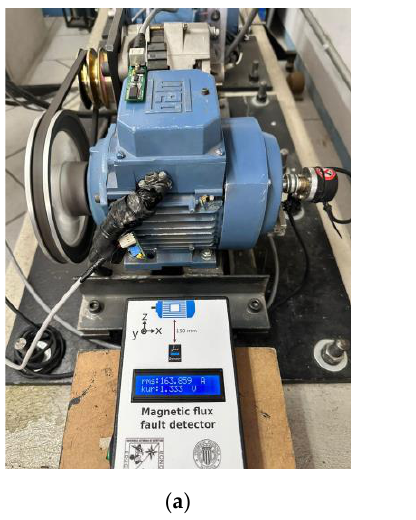
Figure 10. ( a ) SMFFD performing an online fault diagnosis on the induction motor with the bearing having a fault severity of 2 (5 mm); ( b ) observing the results in detail through the digital zoom of the LCD